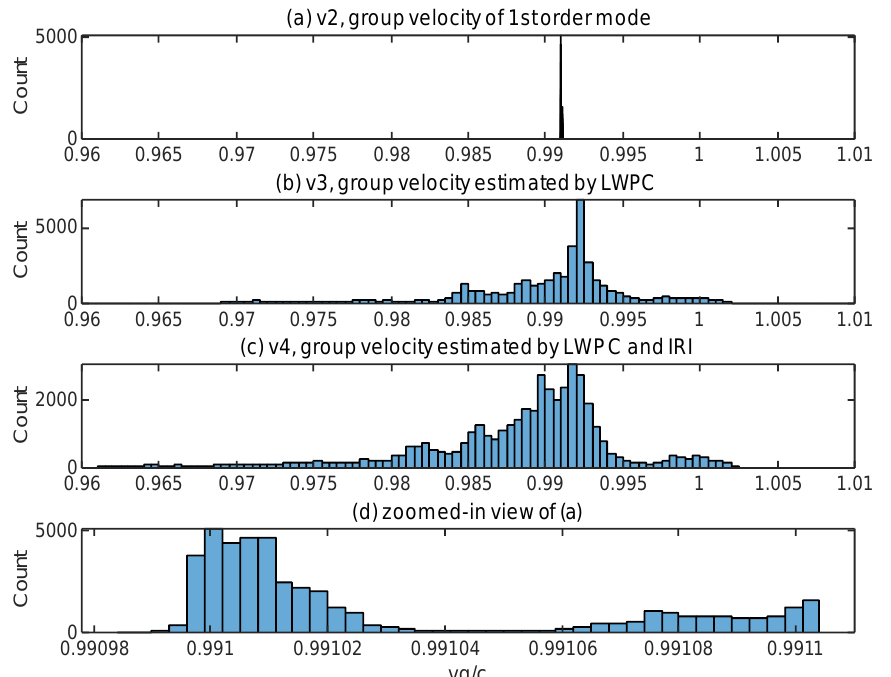
Figure 10. Group velocity statistics for lightning events in Figure 3: ( a ) histogram of group velocities of the first-order mode; ( b ) histogram of group velocities estimated by LWPC; ( c ) histogram of group velocities estimated by LWPC and IRI; ( d ) zoomed-in view of ( a ).